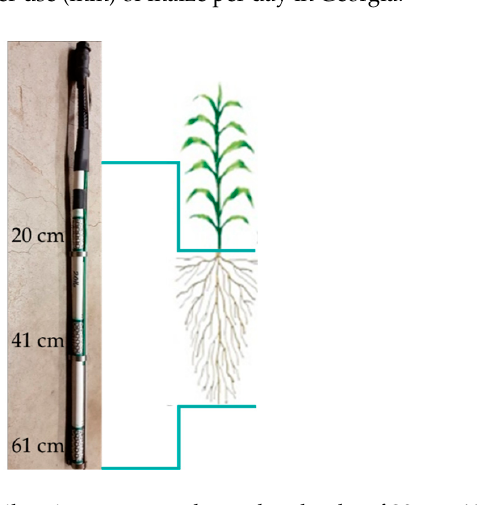
Figure 4. Water use (mm) of maize per day in Georgia.